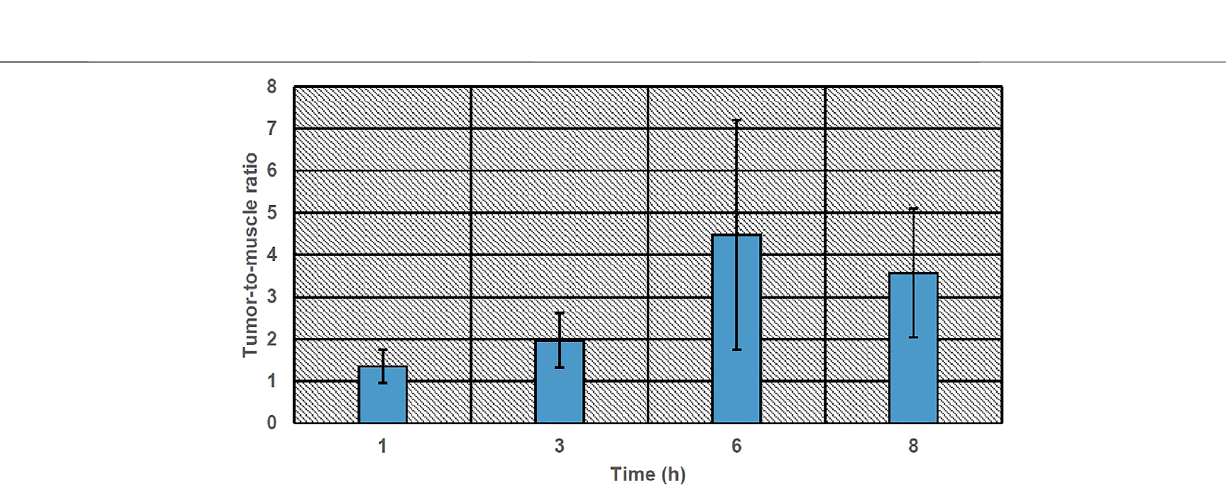
Frontiers in Pharmacology |